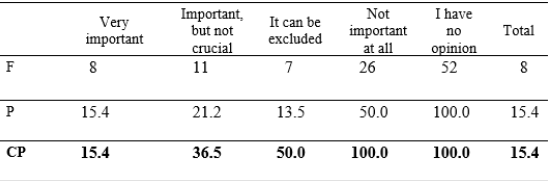
Table 19. Expressive elements or tech- nical